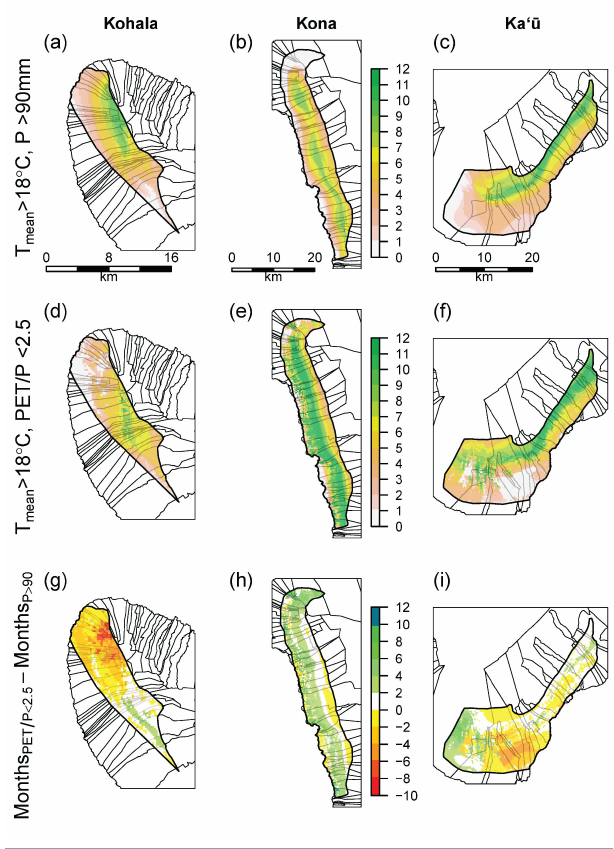
Fig. 7 . Cumulative months meeting ʻ uala (sweet potato, Ipomea batatas ) establishment criteria based on (a–c) temperature and rainfall (Tmean > 18 °C and P > 90 mm), (d–f) temperature and aridity (Tmean > 18 °C and PET/P < 2.5), and the difference of these